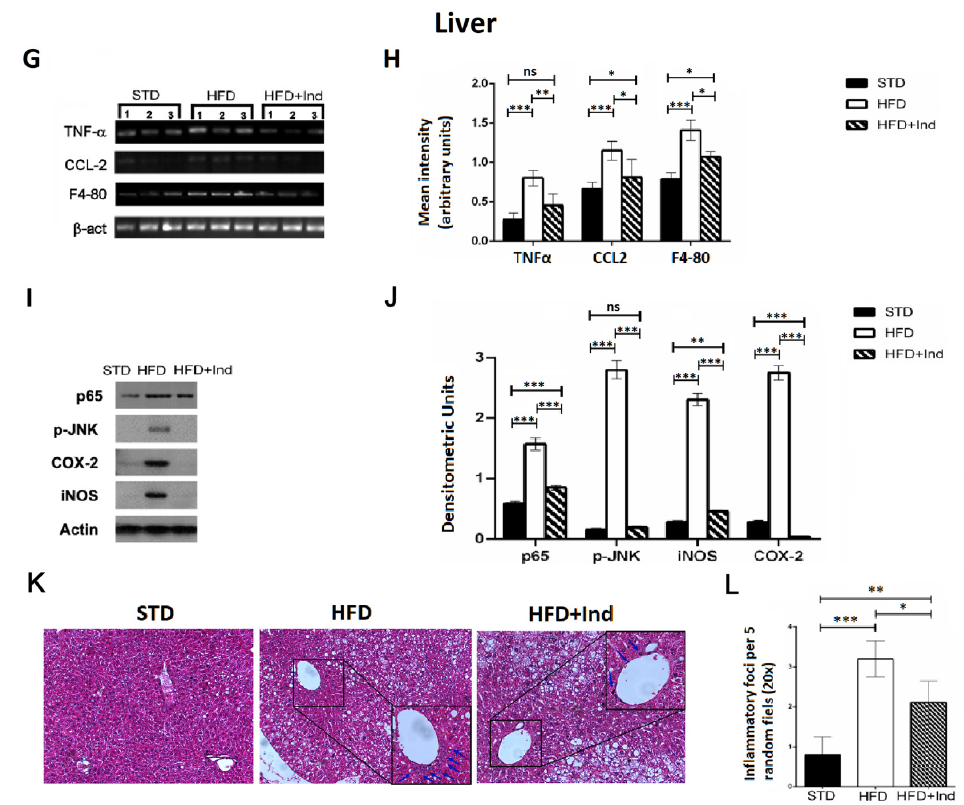
1 Figure 6. Indicaxanthin treatment prevents inflammation in visceral adipose tissue and liver of HFD- fed mice. Immunohistochemistry analysis in epididymal visceral adipose tissue (VAT) for MAC-2 positive macrophages forming CLS (arrows) (magnification 10 × ) ( A ); density of MAC-2 positive CLS in VAT ( B ); mRNA expression of TNF- α , F4-80, and CCL-2 and β -actin by PCR in VAT ( C ) and liver ( G ); densitometric analysis of PCR results in VAT ( D ) and liver ( H ); representative Western blot bands of adipose tissue ( E ) and hepatic ( I ) p65, pJNK, iNOS, COX-2 and β -actin protein expression; densitometric analysis of adipose tissue ( F ) and hepatic ( J ) p65, pJNK, iNOS and COX-2 protein levels normalised for β -actin levels; liver histology of examined by H&E staining ( K ). Arrows indicate the points of inflammatory foci (magnification 10 × ). Quantification of inflammatory foci per 5 random fields under 20 × magnification ( L ). Results are shown as means ± SEM of 8 animals/group. ns: p > 0.05; * p ≤ 0.05; ** p ≤ 0.01; *** p ≤ 0.001 (ANOVA associated with Bonferroni’s